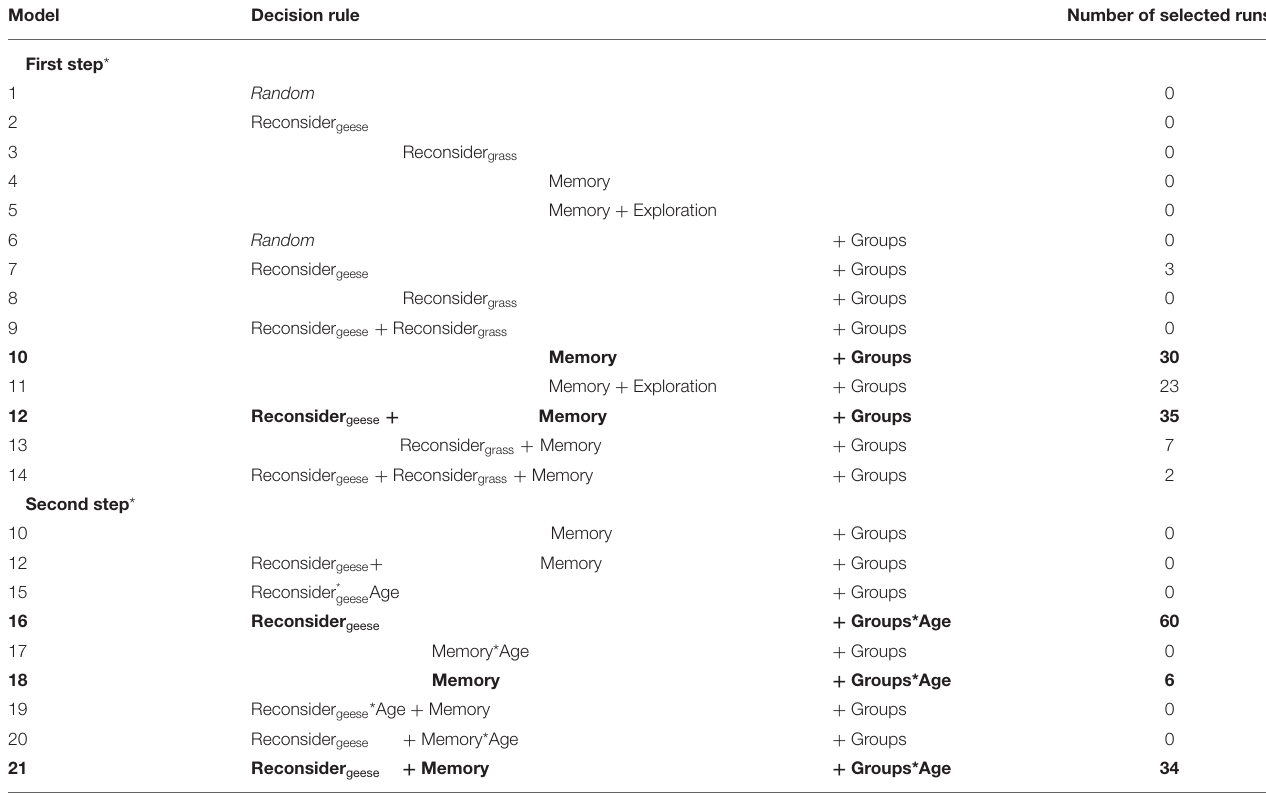
TABLE 2 | Model selection results, showing for each model the number of runs among the best 100 simulation runs.